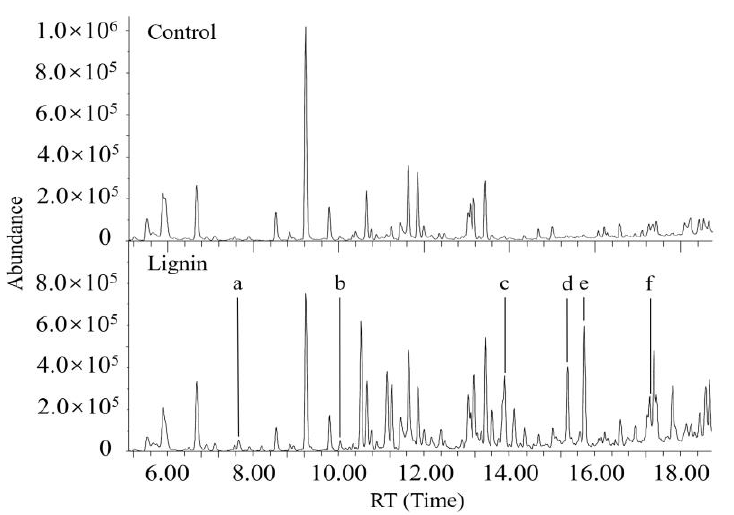
Figure 5. Total ion chromatogram of the compounds extracted from dye degradation in the absence (up) or presence (down) of alkali lignin. a-f show the peaks of chemicals present in the lignin culture. a: methoxybenzene (RT 7.7); b: benzaldehyde (RT 10.0); c: guaiacol (RT 13.9); d: phenol (RT 15.4); e: 4-vinyl guaiacol (RT 15.7); f: ethyl guaiacol (RT 17.2). e: 4-vinyl guaiacol (RT 15.7); f: ethyl guaiacol (RT